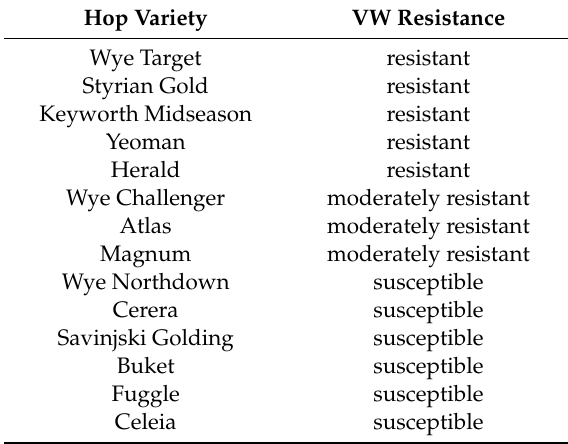
Table 5. List of hop varieties di ff ering in resistance to Verticillium wilt (VW). Hop Variety VW Resistance Wye Target resistant Styrian Gold resistant Keyworth Midseason resistant Yeoman resistant Herald resistant Wye Challenger moderately resistant Atlas moderately resistant Magnum moderately resistant Wye